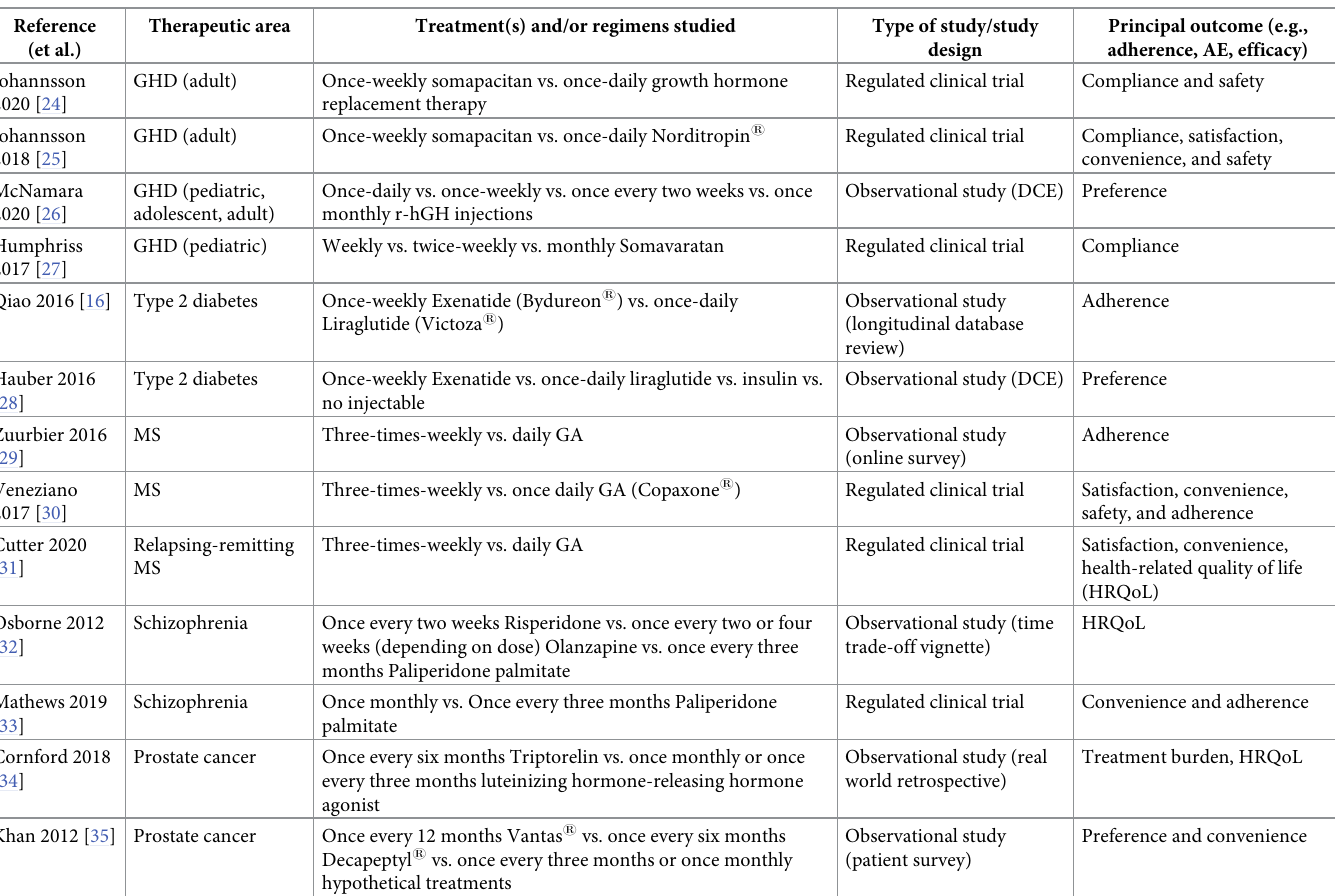
Table 2. Summary of studies included in final review. Reference (et